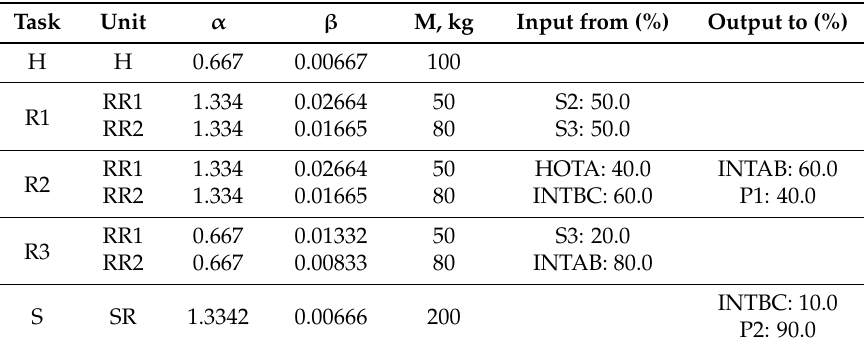
Figure 10. Recipe network for Example 4.